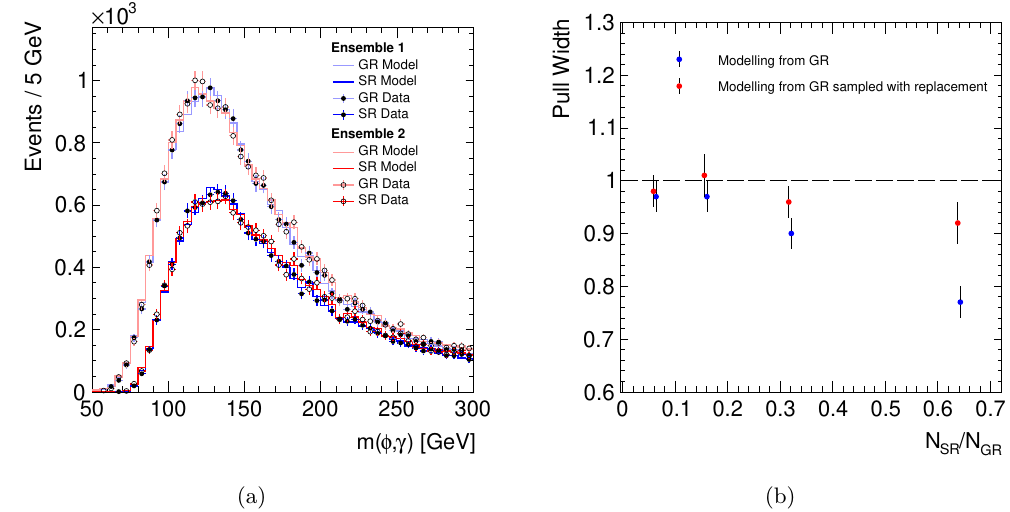
Figure 9 . (a) Data and background model comparison for two distinct experiments in the ensemble. The background model is obtained utilising each of the n GR events once. (b) The width of the pull distribution for ensemble tests with different SR-to-GR event fractions. The red markers have been shifted by -0.5% along the horizontal axis for